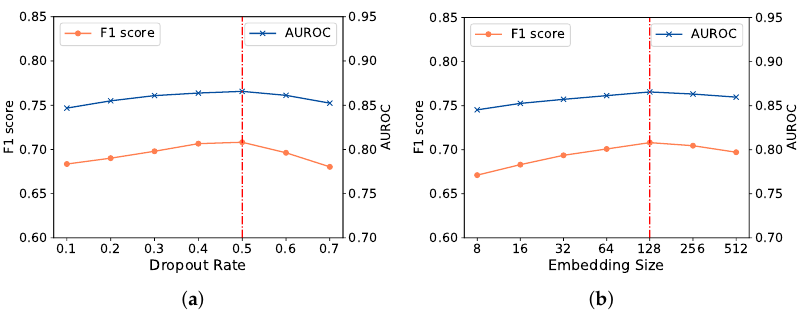
Figure 11. ( a ) Performance comparison with respect to dropout rate; ( b ) performance comparison with respect to embedding